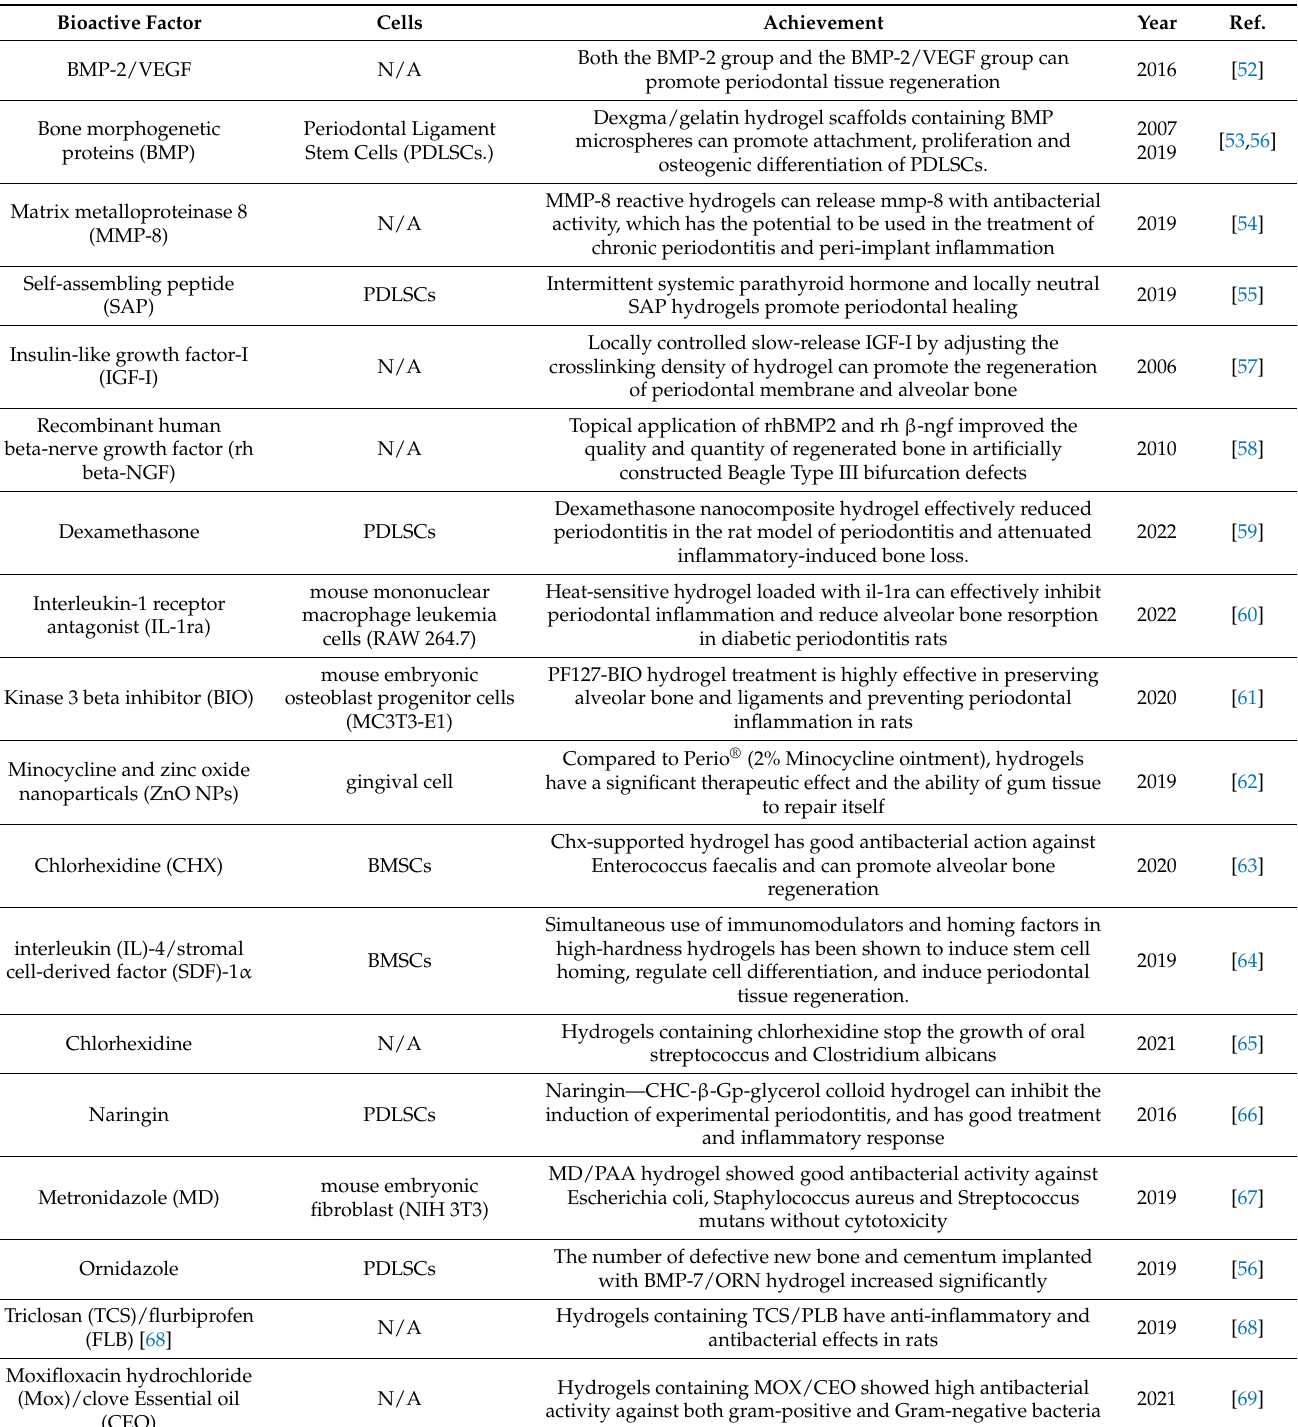
Table 2. Hydrogels loaded with drugs/bioactive factors used for periodontal anti-inflammatory or